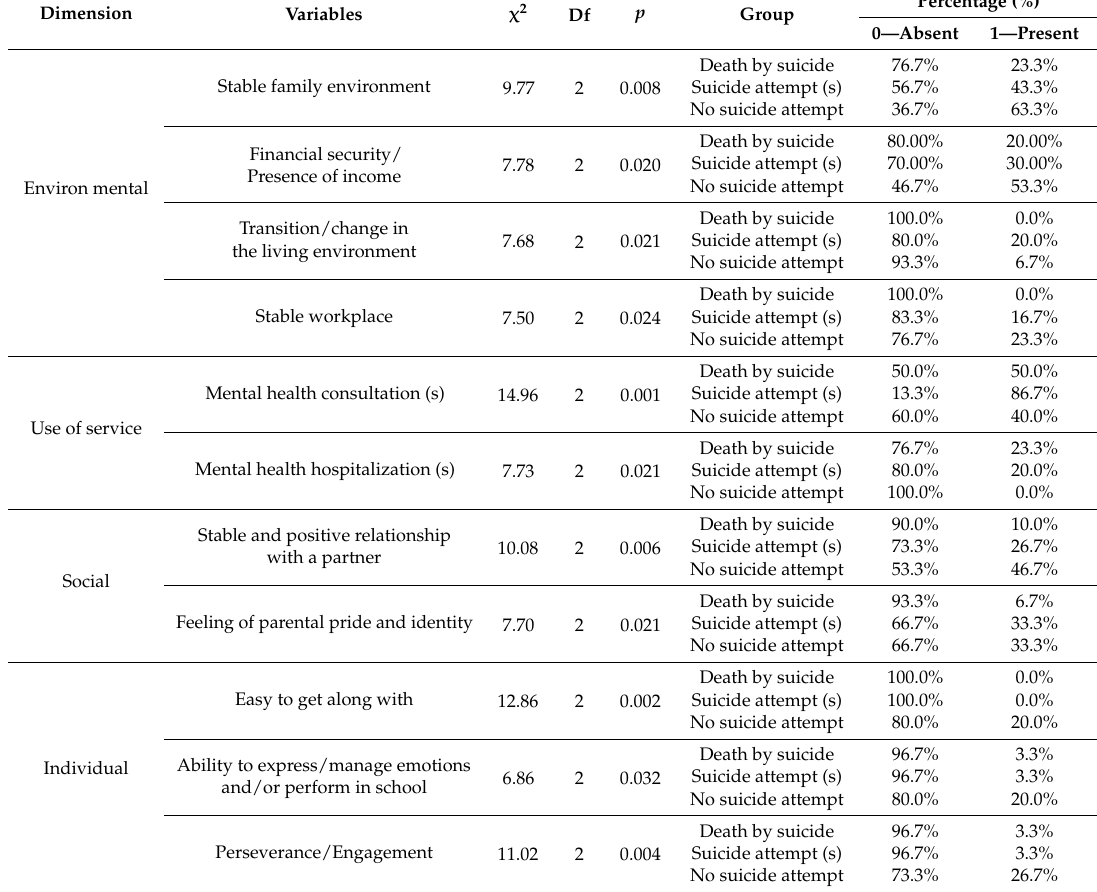
Table 4. Chi-square